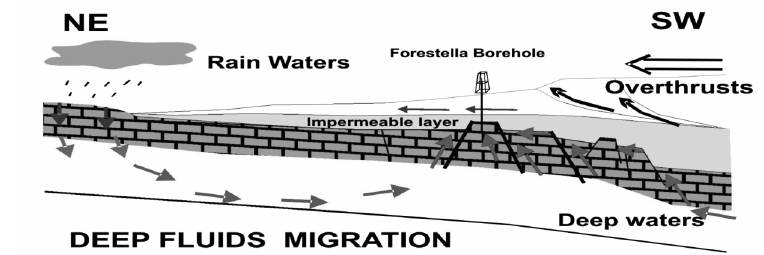
Fig. 6. Schematic section showing the fluids injection and mixing into hydrogeological flow activated by tec- tonics. The red and blue arrows show the direction of fluids